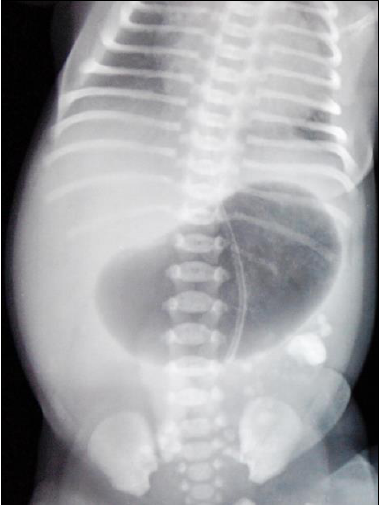
Figure 1: Abdominal radiograph showing single gastric bubble and calcification in left iliac